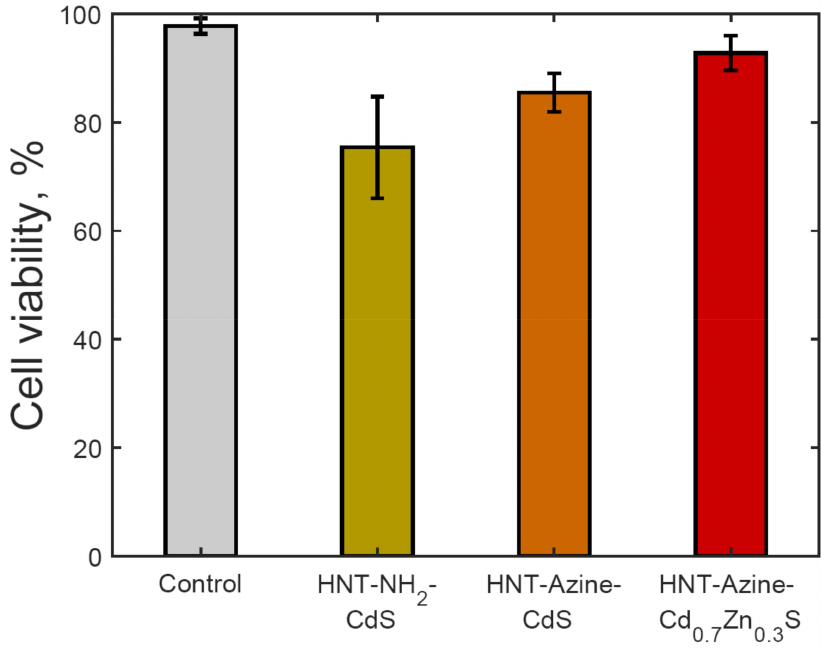
Figure 6. Flow cytometry data on viability of PC-3 cells exposed to halloysite-QD composites. Error bars are sample standard deviations (see also Figures S5–S8 in Supplementary